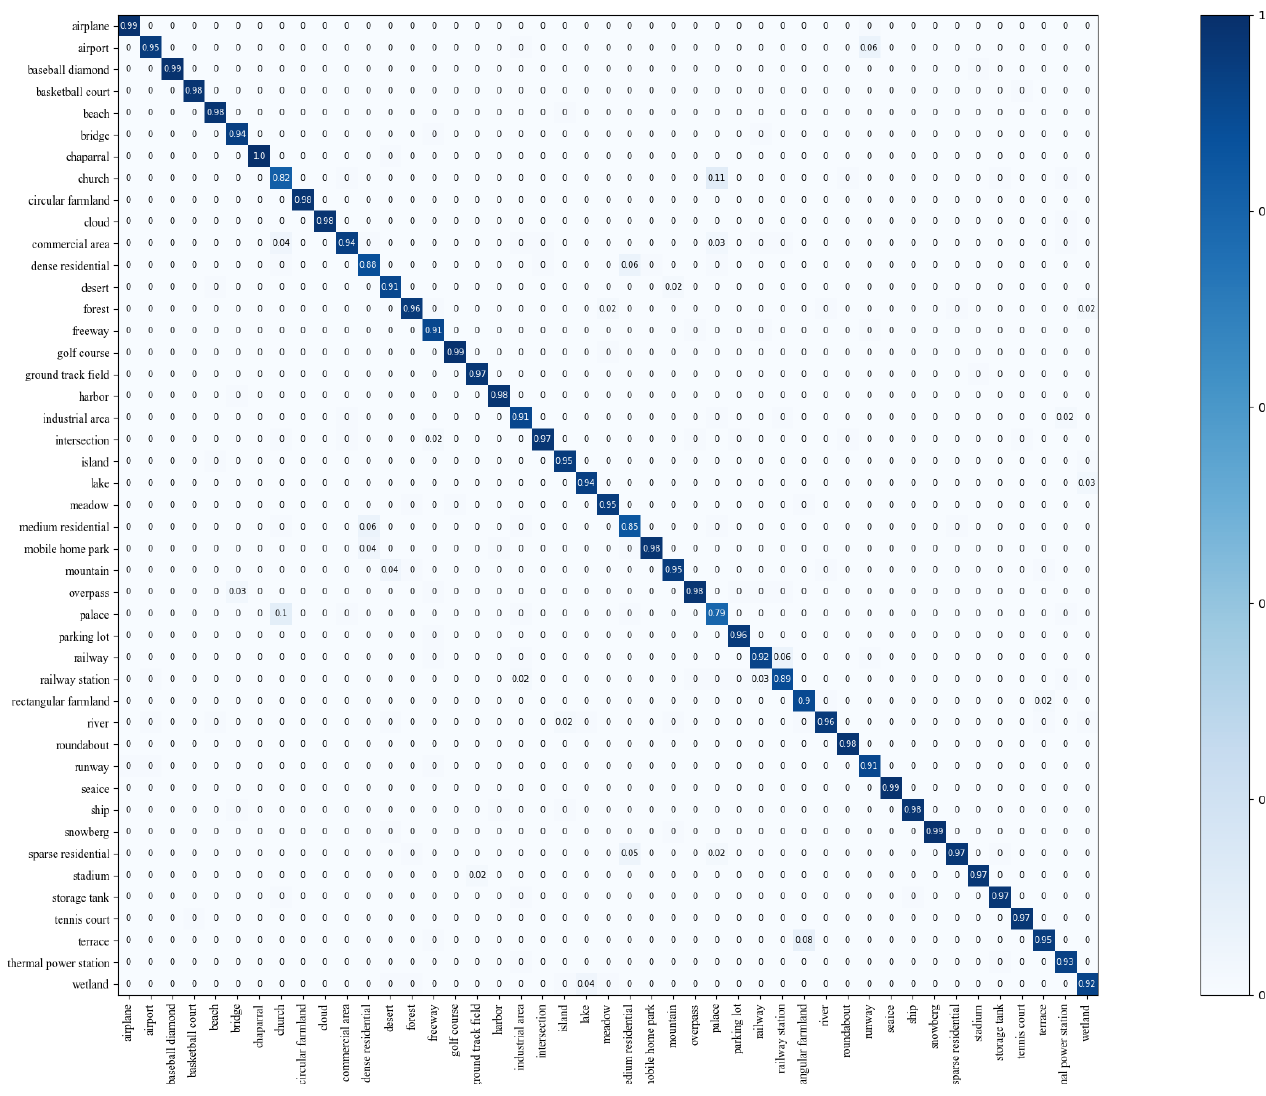
Figure 5. Confusion matrix in NWPU-RESISC45 using LSRL at training ratio of